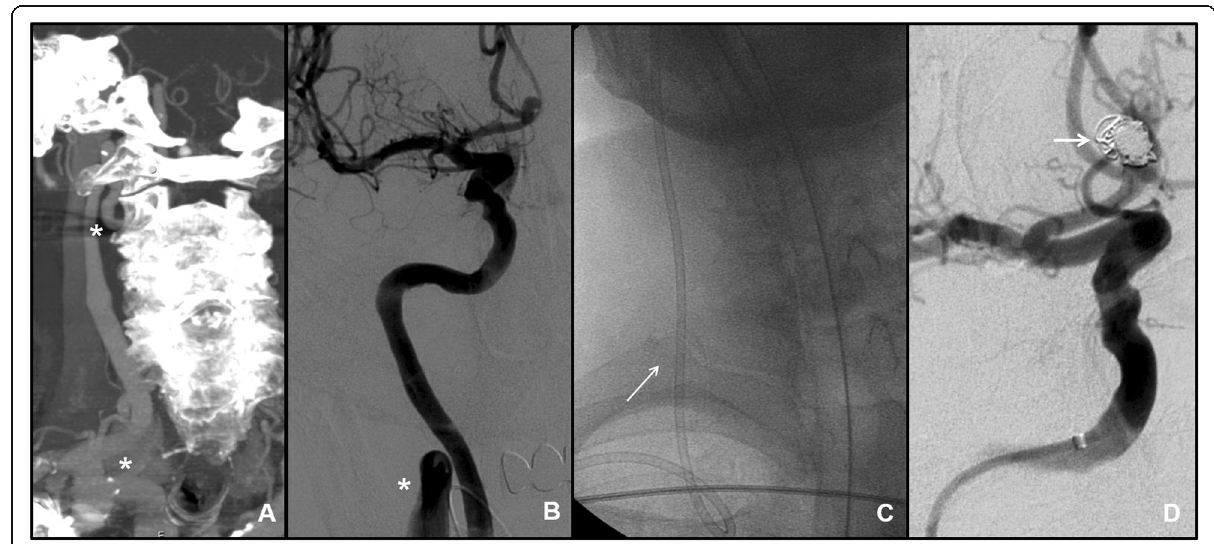
Fig. 4 Sub-arachnoid hemorrhage with ACoA aneurysm in a 76-year-old man. Right trans-radial access was chosen because of a double kinking at CCA and ICA origin evaluated at CT-angiography and during DSA (asterisks in a and b ). A 6 Fr guiding catheter was advanced for distal access into proximal ICA and simple coiling was obtained with compete aneurysmal occlusion (arrow in d